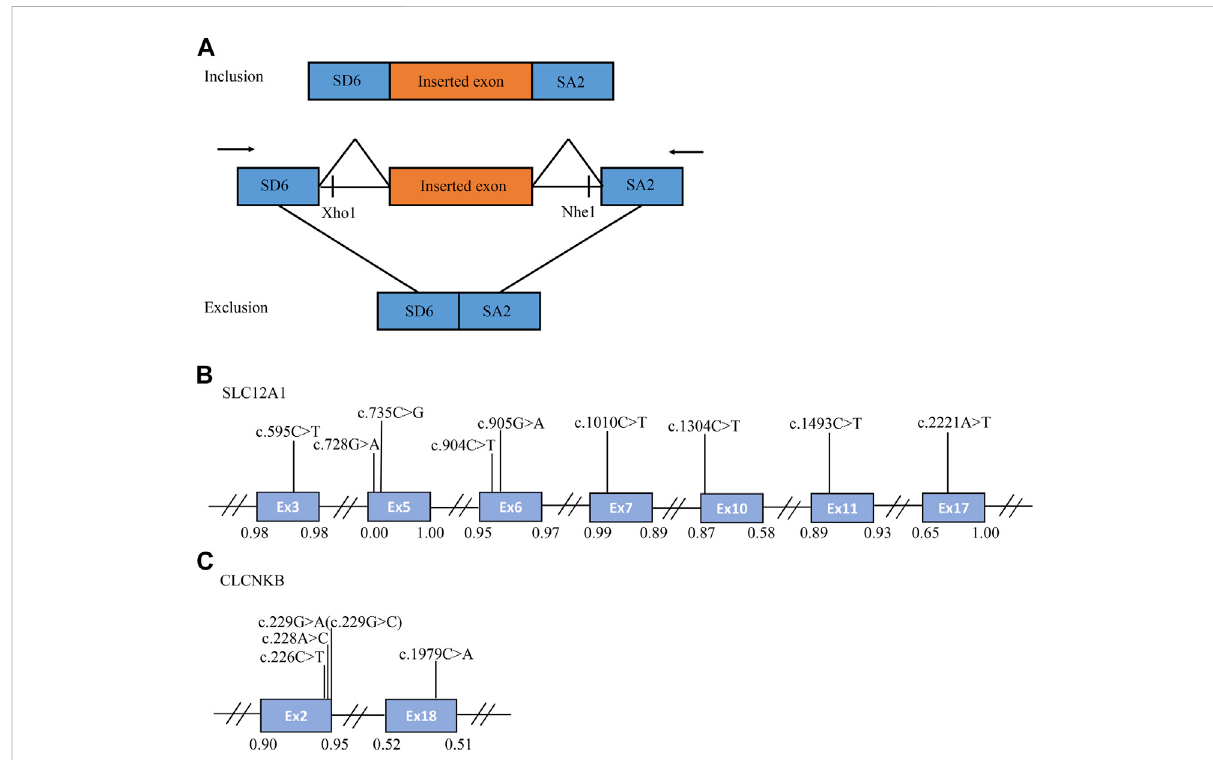
FIGURE 1 The schematic diagram of minigene based on the pSPL3 exon trapping vector and position of 14 presumed exonic variants. (A) Wild-type and mutantfragmentsoftargetexon, fl ankedbypartoftheupstreamanddownstreamintronicsequence,wereseparatelyclonedintotheXhoIandNheI cloningsitesofthepSPL3vector (B,C) Positionofpresumedexonicvariantsin SLC12A1 and CLCNKB gene.Blueboxesandblacklinesbetweenthem representthecodingexonsandintronssequences,respectively.Theirsizesarenotproportional.TheBDGPscoresofdonorandacceptorsplice sites are represented in